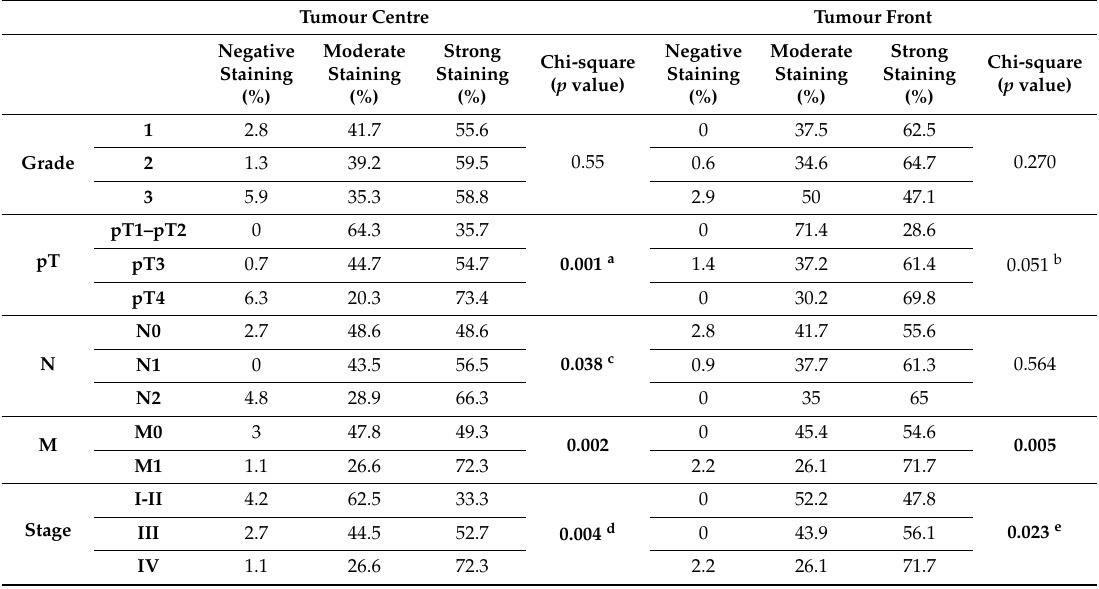
Table 3. PRR protein expression levels according to the di ff erent pathological parameters in the centre and the infiltrating front of the analysed primary tumours. Tumour Centre Tumour Front Moderate Strong Moderate Strong Negative Negative Chi-square Chi-square Staining Staining Staining Staining Staining Staining ( p value) ( p value) (%) (%) (%) (%) (%) (%) 1 2.8 Grade